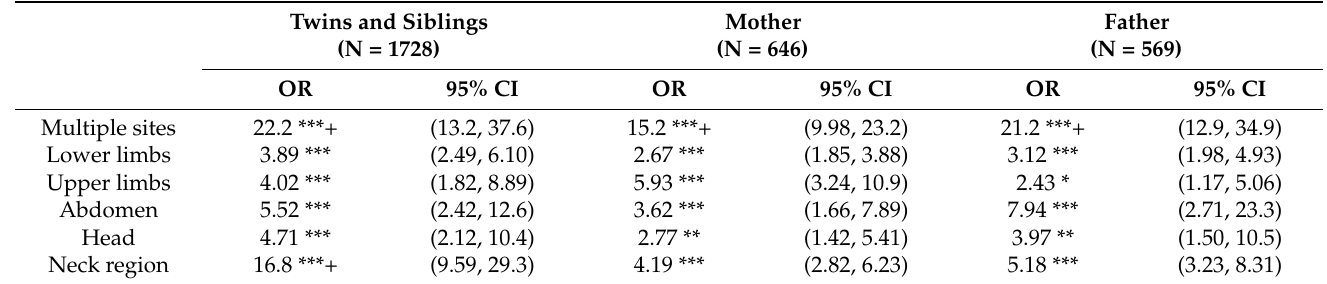
Table 8. Associations between pain in other body regions and current one-month prevalence of thoracolumbar back pain (TLBP).